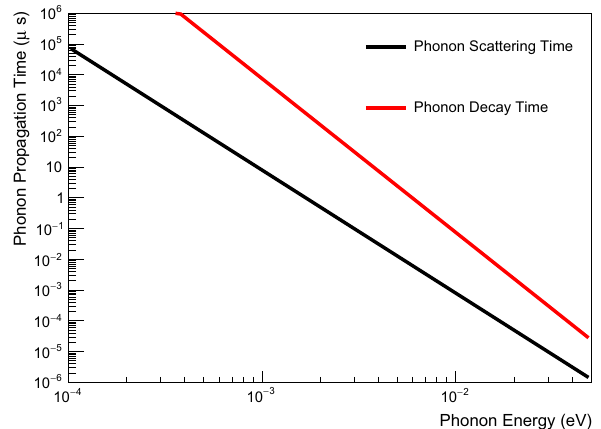
Fig. 7 Shown is the average distance diffused before an anharmonic decay process as a function of phonon